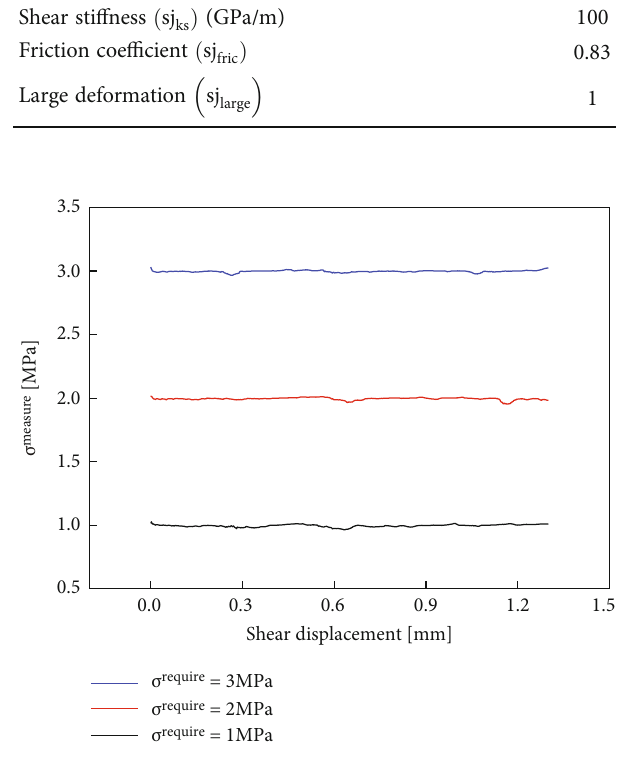
Figure 5: Comparison between the σ measure and σ require